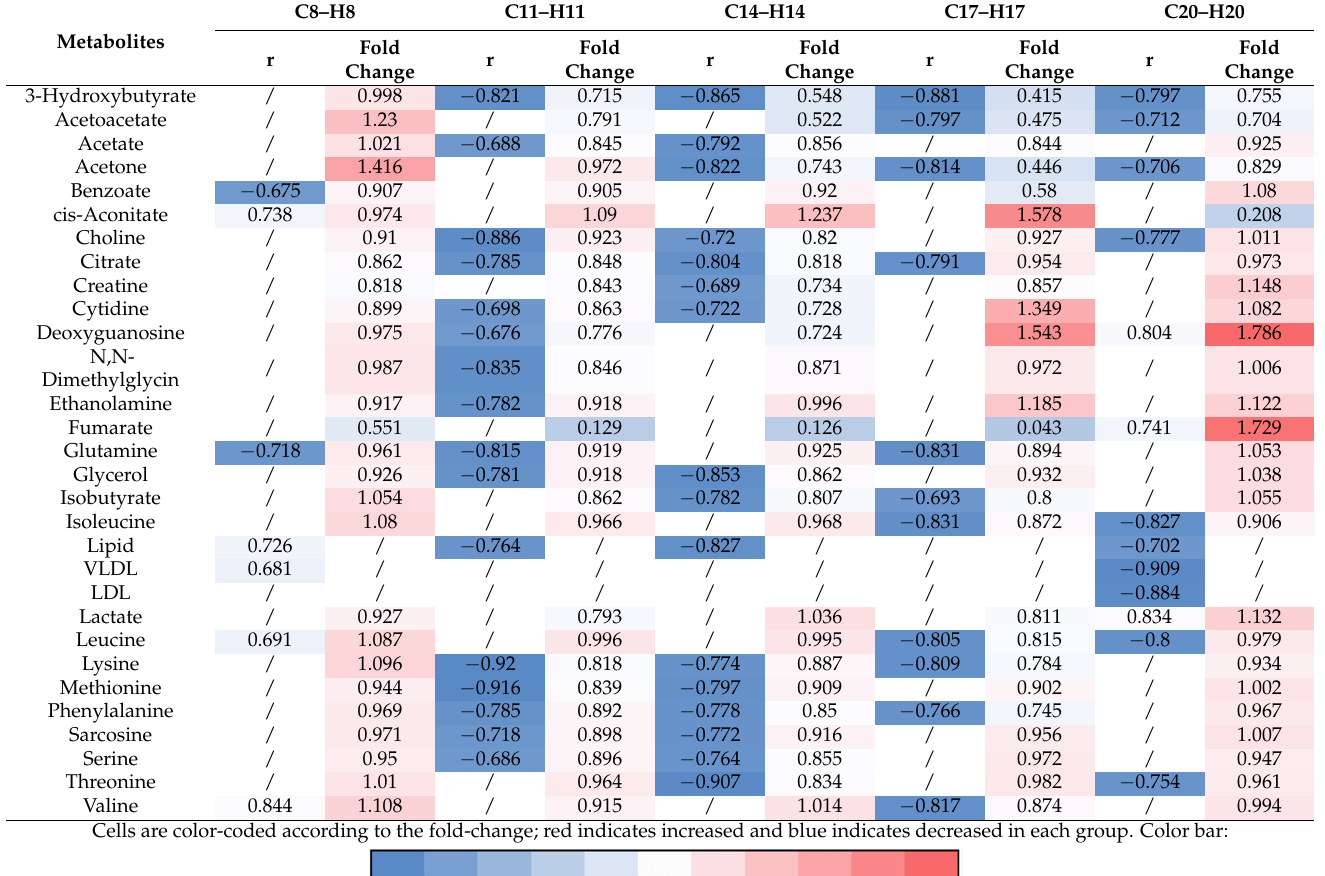
Table 1. Differences in plasma metabolism between hypoxia group and control group.